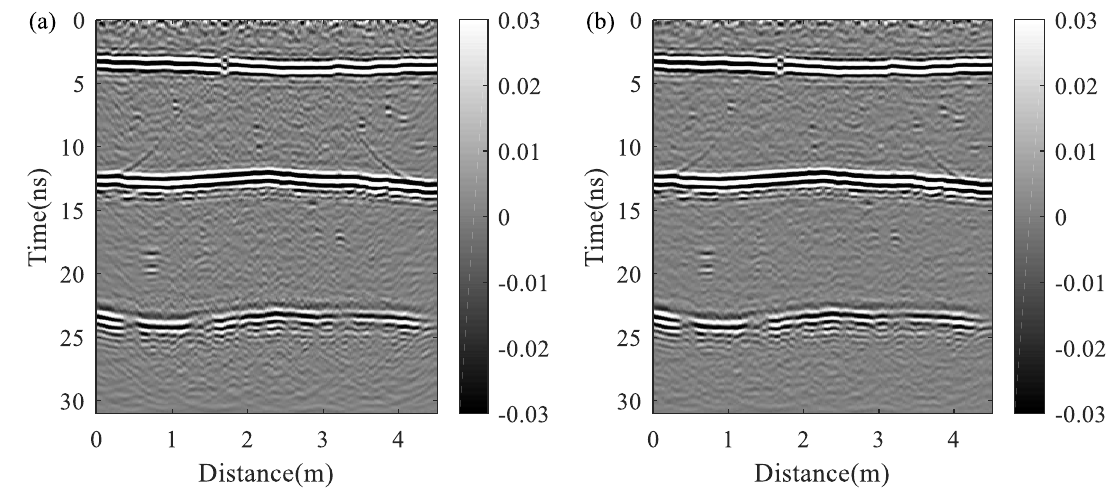
Figure 4. 2D-PCA denoising effect comparison. ( a ) Average profile of FP-SPR data after Kirchhoff integral migration processing. ( b ) Profile reconstructed by 2D-PCA.